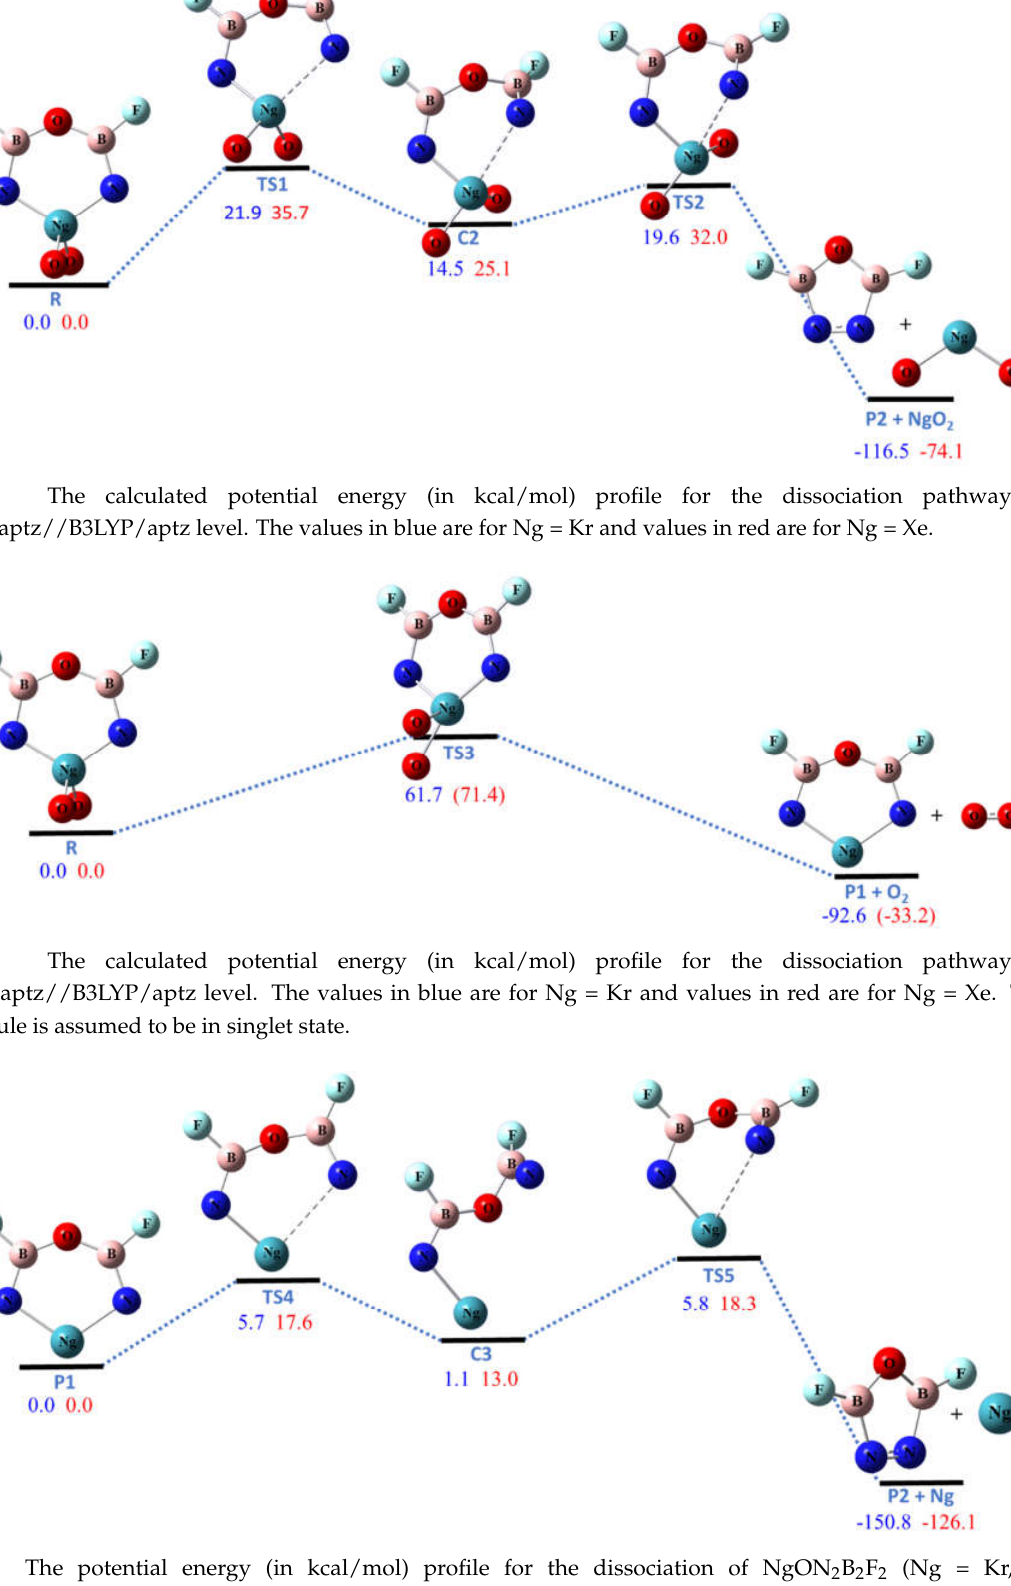
CCSD(T)/aptz//B3LYP/aptz level. The values in blue are for Ng = Kr and in red are for Ng = Xe.